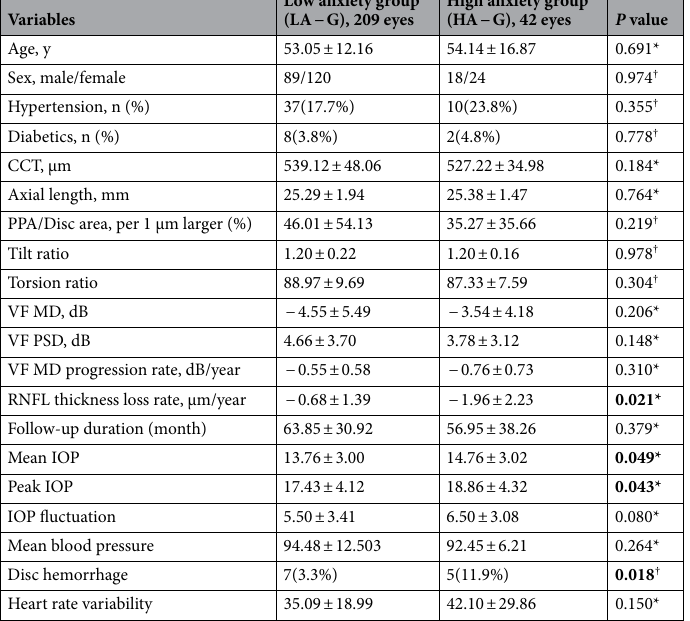
Table 2. Comparison of the demographics and test results between two groups divided according to the Beck Anxiety Inventory (BAI) scale. CCT, central corneal thickness; PPA, peripapillary atrophy; VF, visual field; MD, mean deviation; PSD, pattern standard deviation; RNFL, retinal nerve fiber layer; IOP, intraocular pressure. *The comparison was performed using independent samples t-test. † The comparison was performed using a chi-squared test. Continuous data are mean ± mean standard deviation unless otherwise indicated. Statistically significant values appear in boldface.